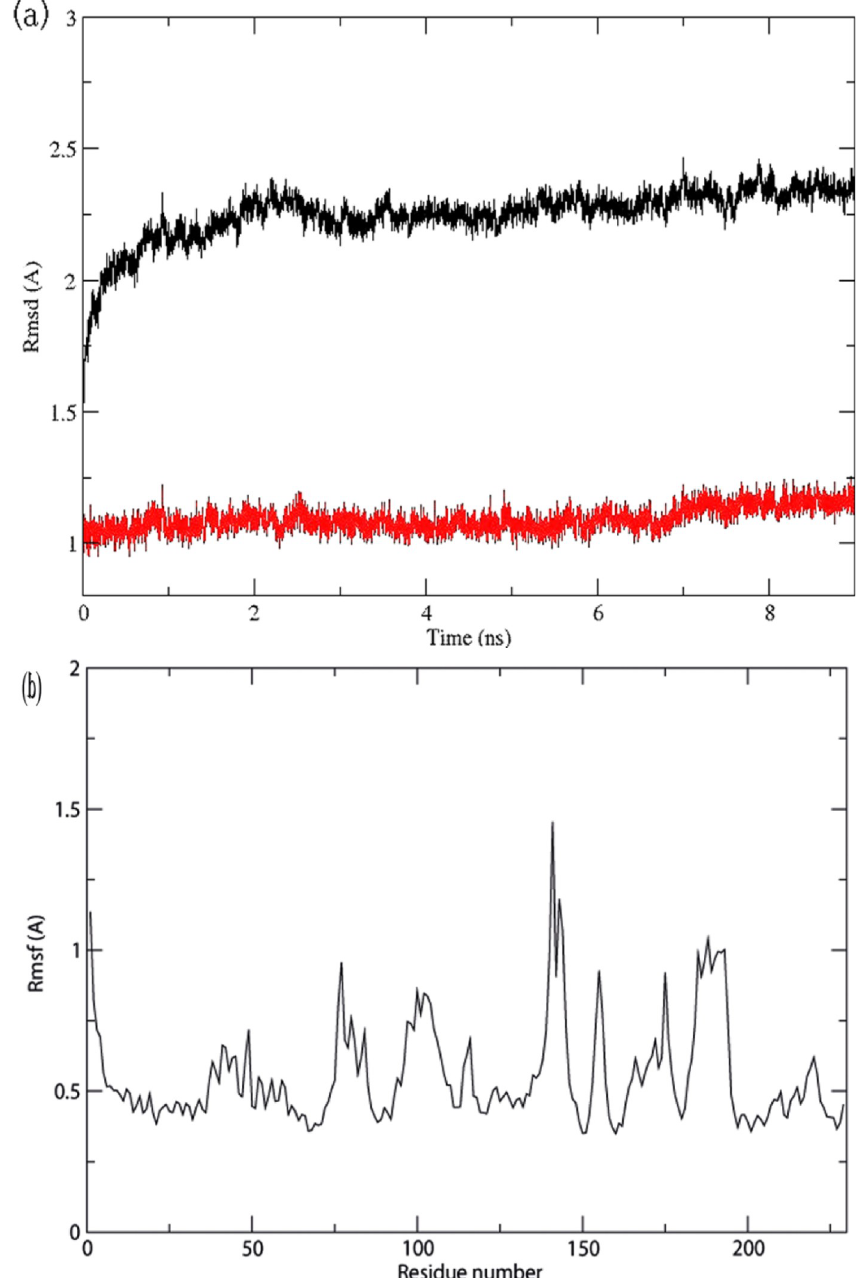
Fig 5. Molecular Dynamics (MD) profiles of the S . aureus HK 3D structure optimization. a) Root-mean-square deviation (RMSD) values (y-axis) along the time frame (x-axis) for atoms of the protein backbone (red lines) and all protein atoms (black line), and b) root-mean-square fluctuation (RMSF) values (y-axis) in the MD simulation for individual residues